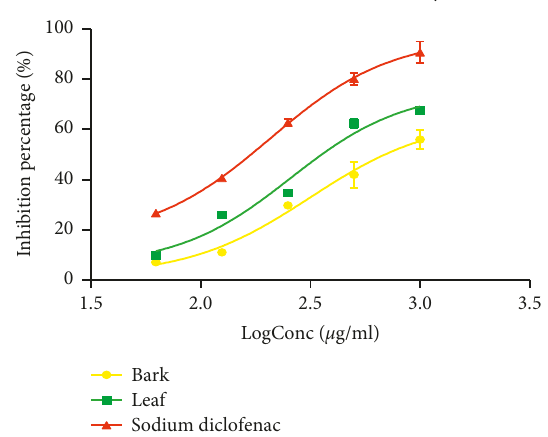
Data are expressed as mean ± SD; n � 3; mg CE/g of extract: milligram catechin equivalent per gram of extract. Significantly different at ∗∗∗ p < 0 . 001 and ∗∗ p < 0 .